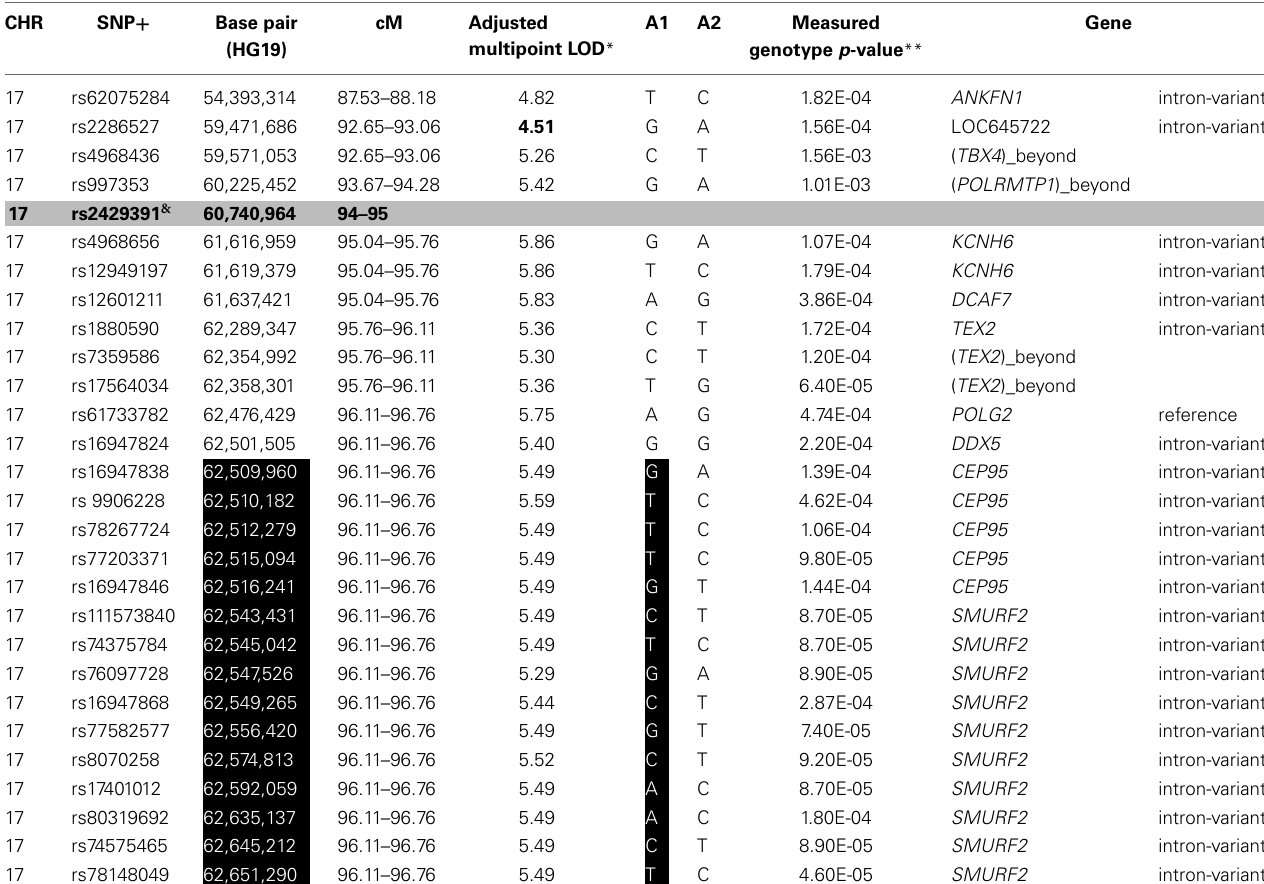
Table 5A | SNP and haplotype association under the 17q23.2 linkage peak.